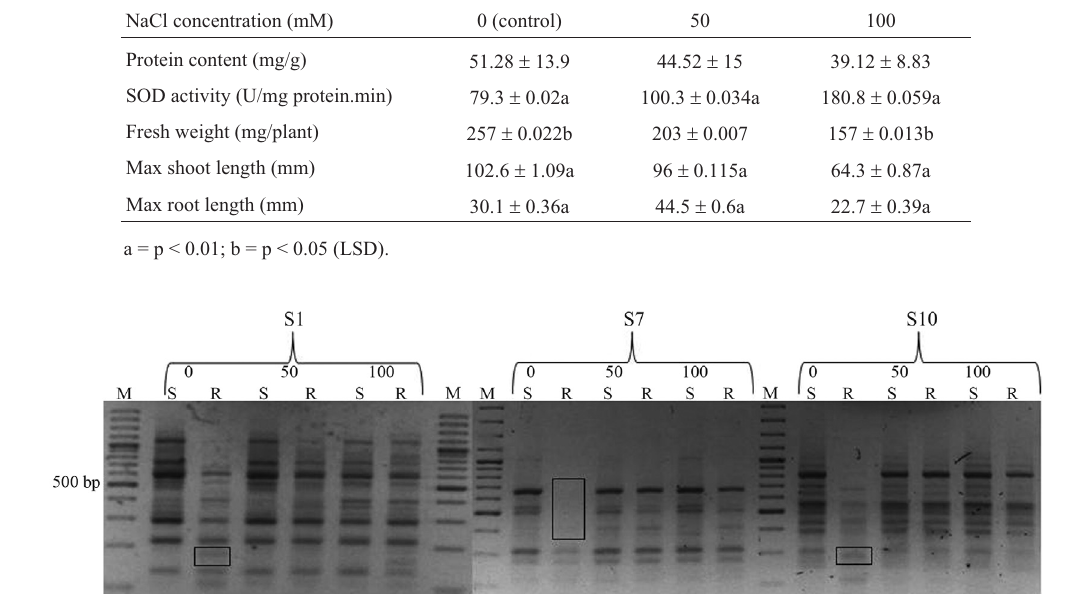
Figure1 -RAPDresultsofprimersS1,S7andS10.0,50and100representNaClconcentrations(mM).Polymorphicbandsareindicatedbyrectangles.